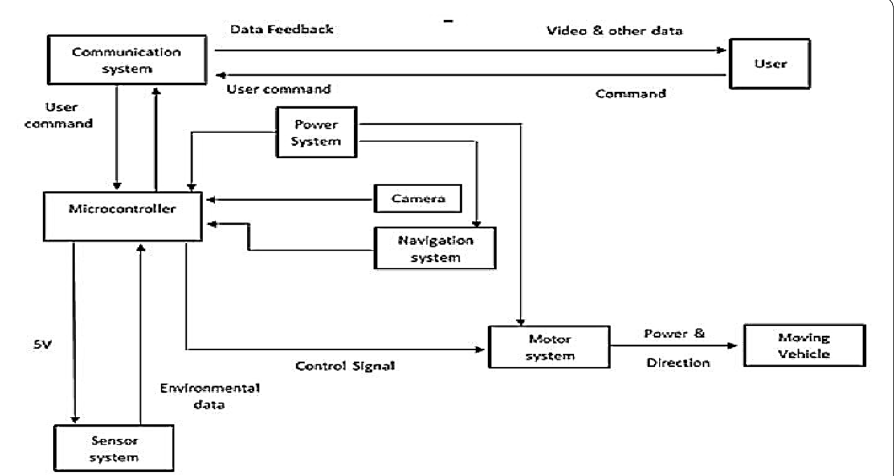
Fig. 2 Block diagram of the sensor system